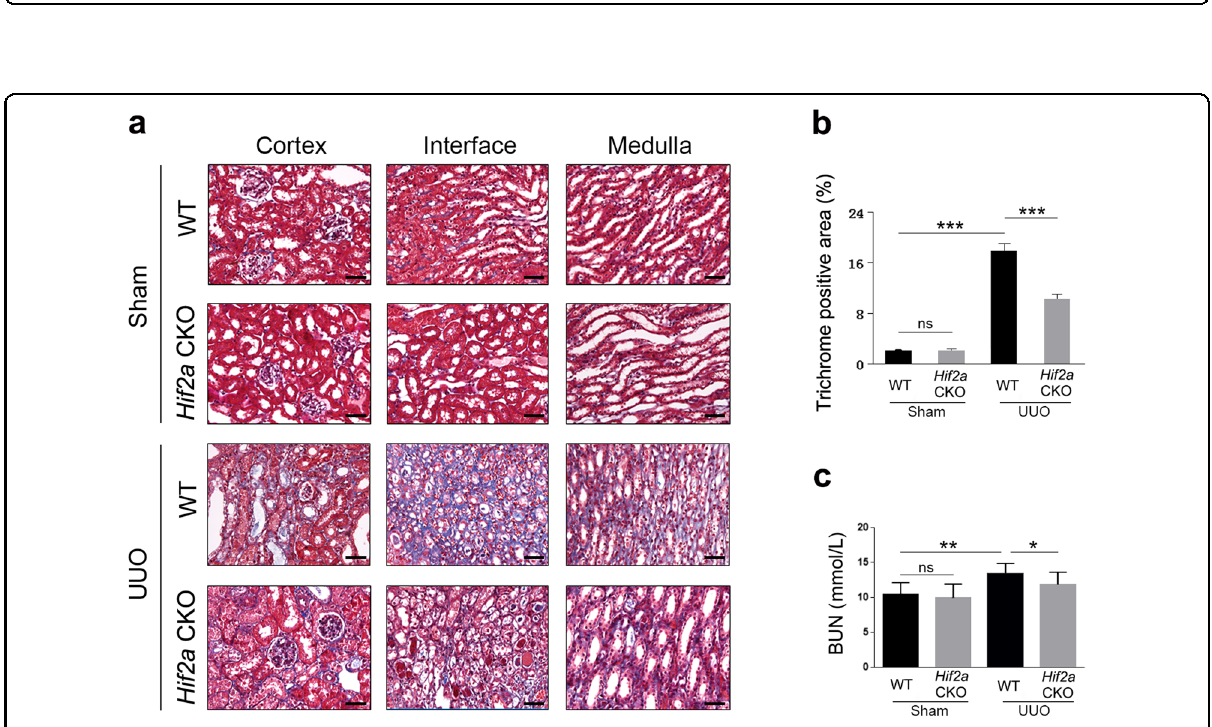
Fig. 6 Hif2a de fi ciency ameliorates renal fi brosis induced by UUO surgery. a Masson-trichrome staining showing fi brosis was reduced. Scale bar = 20 μ m. b Quantitative analysis of the data shown in a . c BUN levels was decreased in Hif2a CKO mice. n = 6. Data are means ± SEM. ns means no signi fi cance. * P > 0.05, ** P < 0.05, *** P <